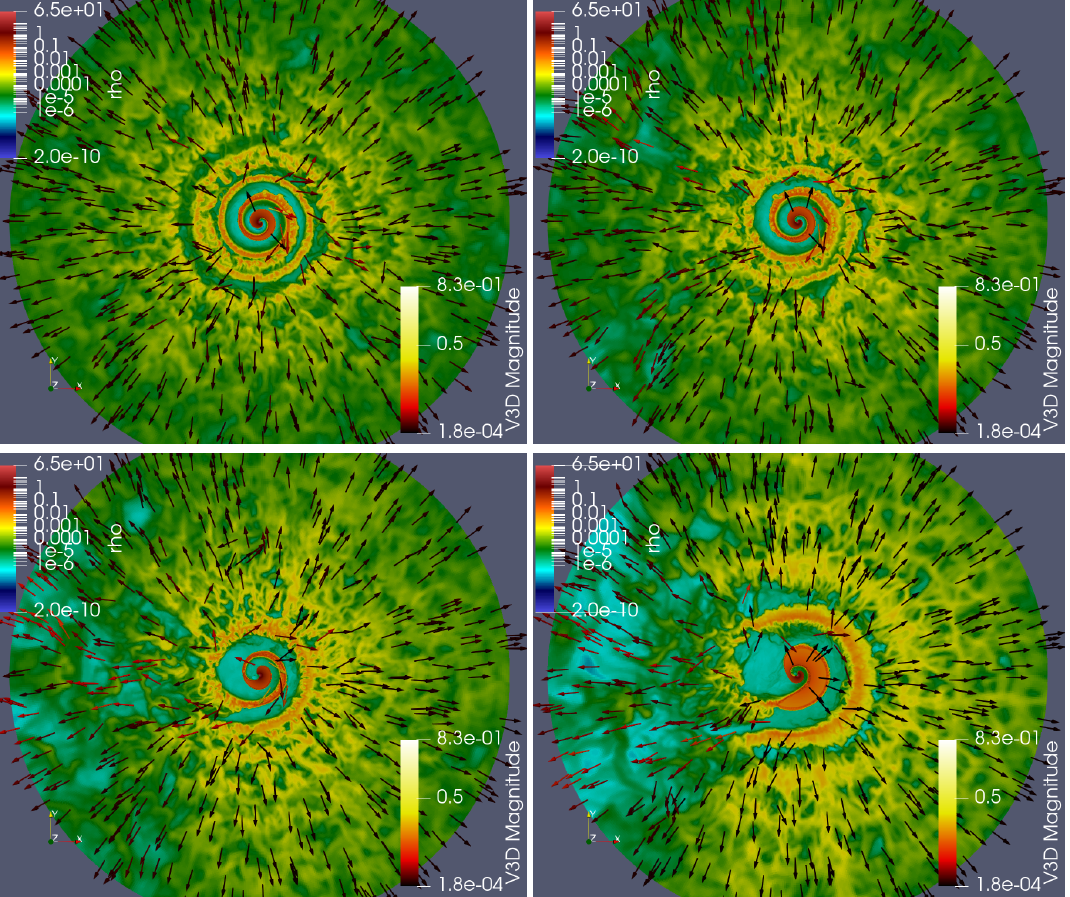
Figure 1. Maps for the whole computational domain of the logarithm of the density distribution on the orbital plane by color, with colored arrows representing the velocity field, for different eccentricities: e = 0 ( top-left panel ); e = 0.25 ( top-right panel ); e = 0.5 ( bottom-left panel ); and e = 0.75 ( bottom-right panel ). The radius of the circular grid region shown is 1000 ( 1 − e 2 ) a , and units of the legend scales are a = 6 × 10 12 cm. The periastron-apastron direction is to the